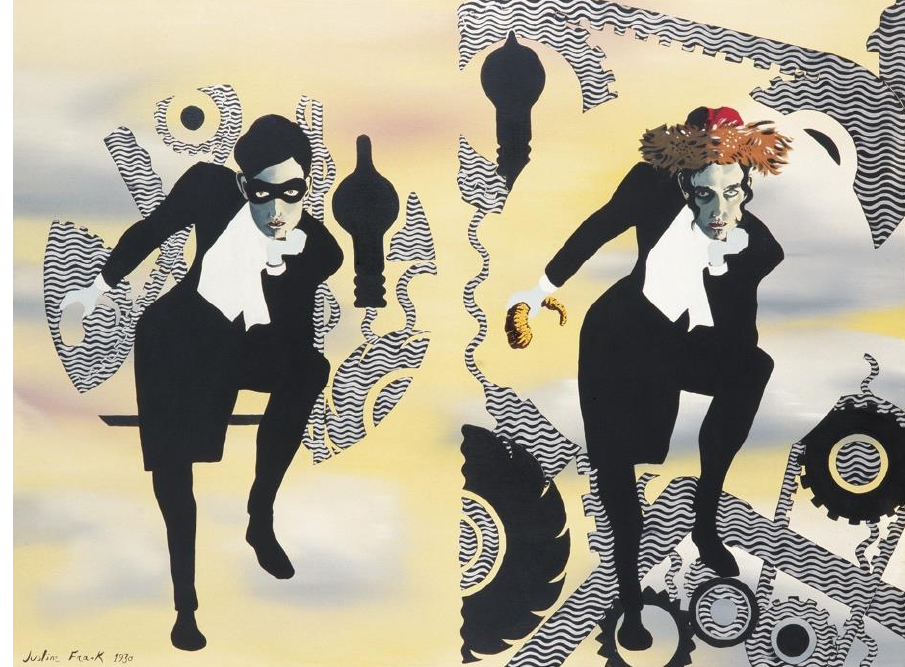
Figure 23. Justine Frank, The Frankomas Sisters , 1930, oil on canvas, 90 × 120 cm. Courtesy of the artist.